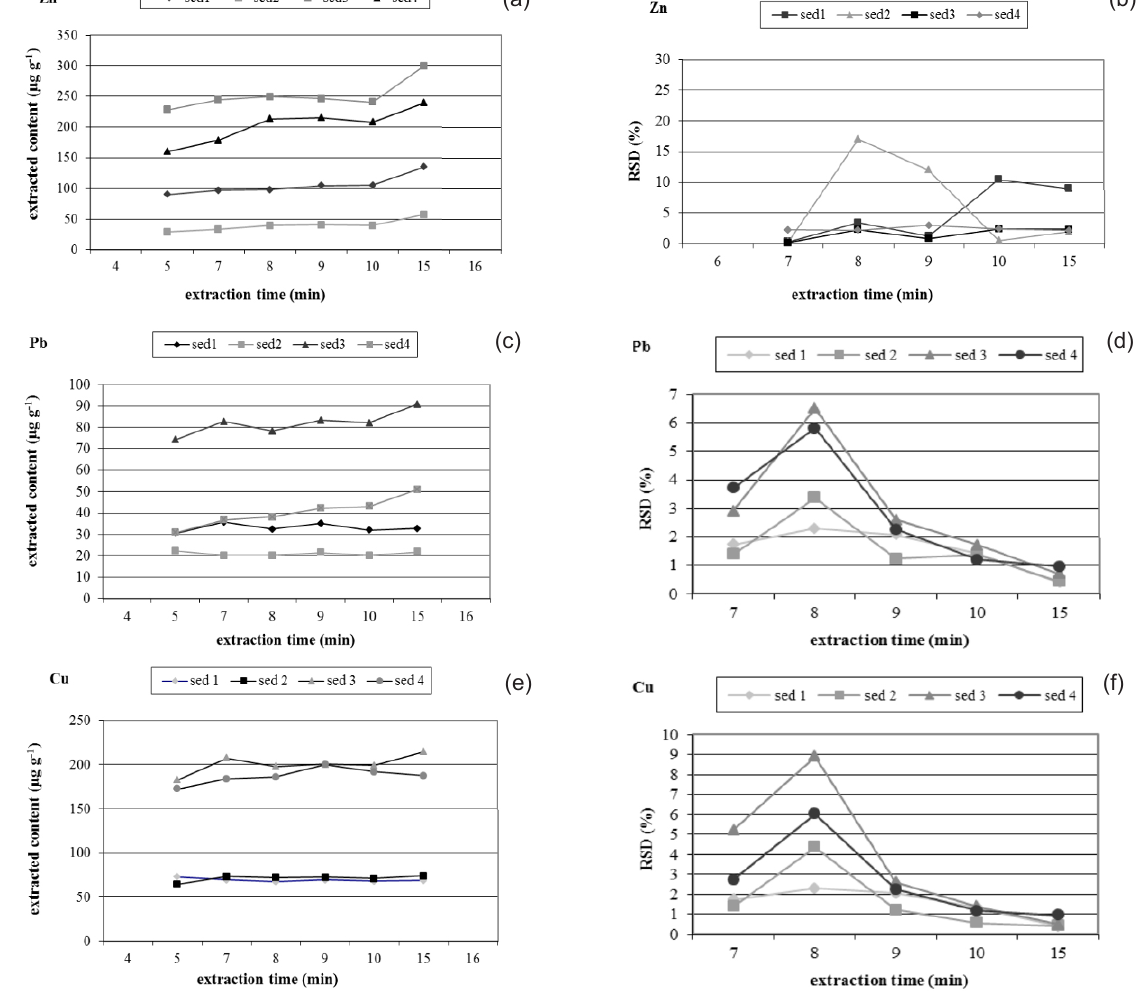
Figure 4. The optimization of the extraction time (USAE), the determination of (a) Zn, (c) Pb and (d) Cu extracted portions in the sediments and the relative standard deviation (RSDs) by time optimization for Zn, Pb, and Cu ( (b), (d), and